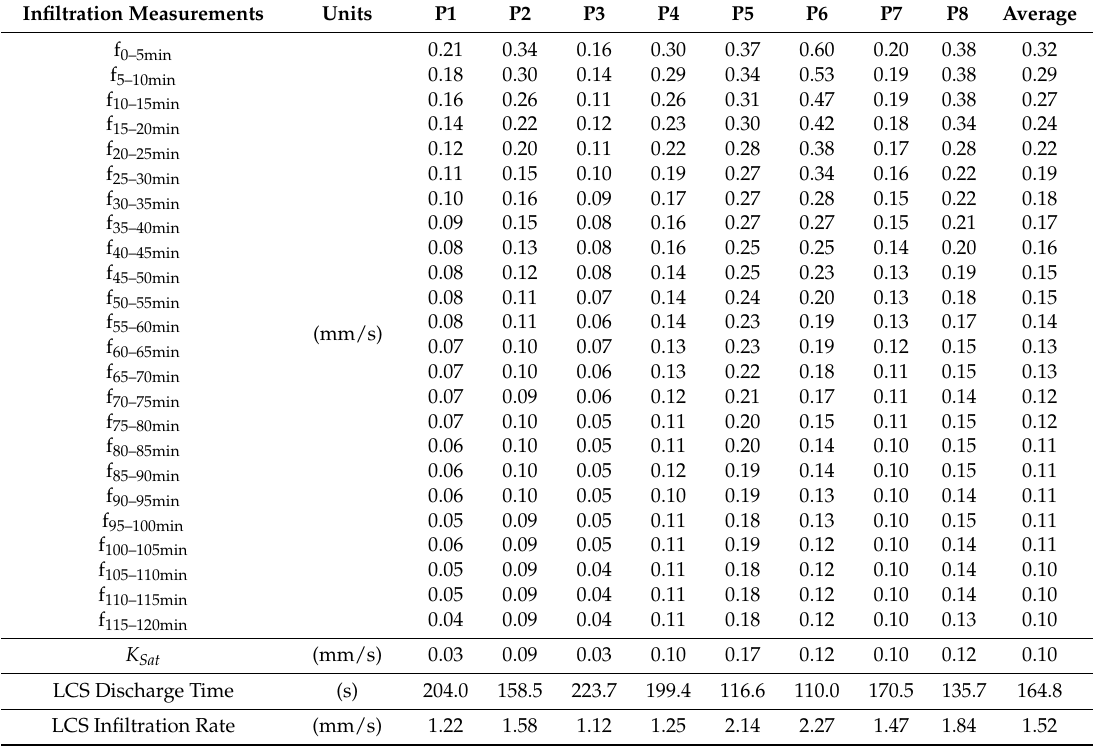
Table 3. Infiltration test results for clogged porous concrete (PC) specimens. Results are unsaturated infiltration rates at different times of the unsaturated constant head experiment and P1 through P8 indicate the tested specimens. The saturated value ( K Sat ) indicates results from the saturated constant head experiment and the LCS discharge time and equivalent infiltration